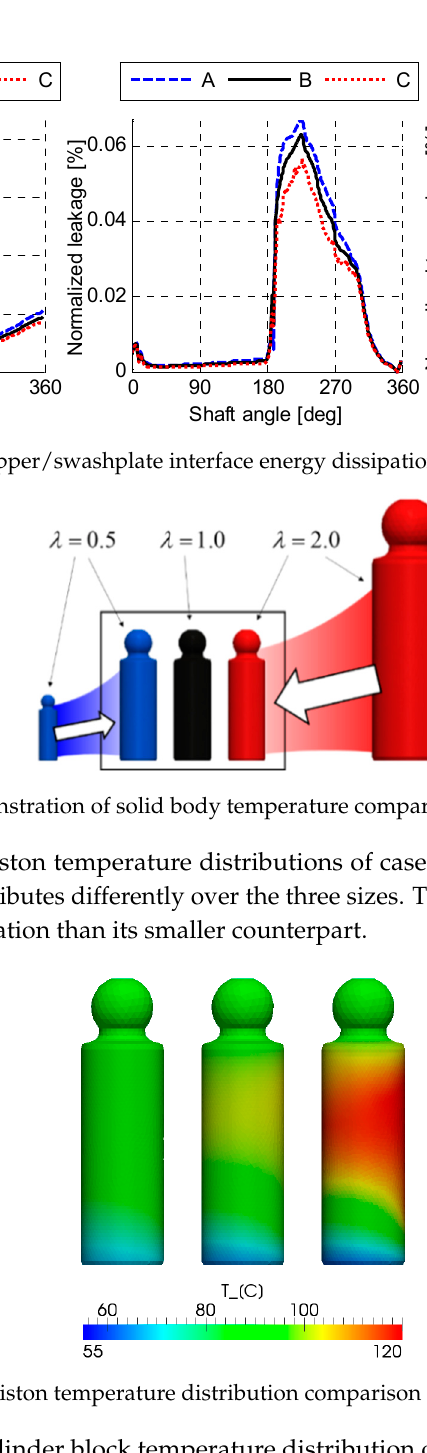
Figure 19. Slipper temperature distribution comparison for different sizes.